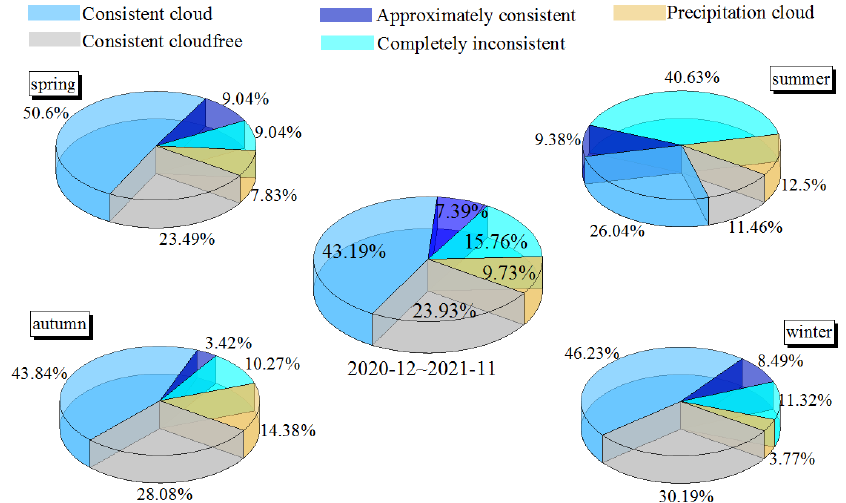
Figure 9. Percentages of the sample sizes in different cases: completely consistent (radiosonde and MMCR detect cloud-free and cloud conditions simultaneously), approximately consistent (numbers of cloud layers detected by radiosonde and MMCR are different), and completely inconsistent (radiosonde detects cloud and MMCR detects cloud-free condition, or MMCR detects cloud and radiosonde identifies a cloud-free scenario).The upper left , the upper right , the lower left and the lower right corner are spring, summer, autumn and winter respectively, and the middle of the figure is the annual record from December 2020 to November 2021.